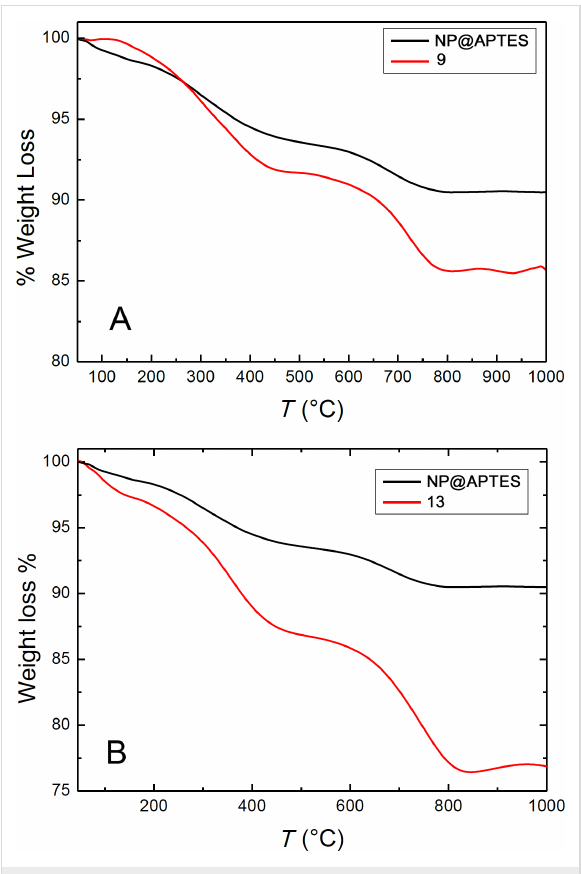
Figure 2: Thermogravimetric analysis profiles for precursor NP@APTES nanoparticles and for conjugate 9 (A) and 13 (B).